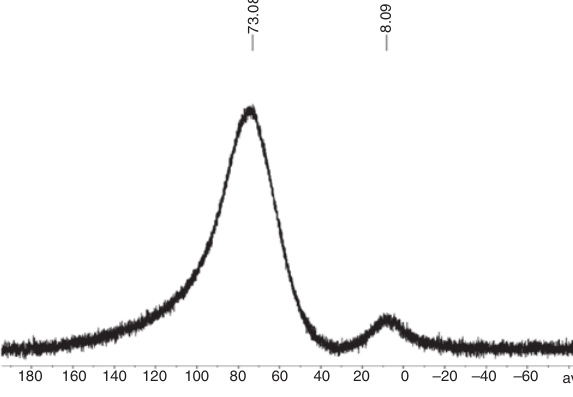
Figure 1: 27 Al NMR of [CH 3 C(O)C:C(O)N(Ph)N:CCH 3 ] 2 Al( µ -O Pr i )2Al(OPr i ) 2 ] [CH 3 C(O)C:C(O)N(Ph)N:CCH 3 ] 2 Al( µ -O Pr i )2Al(OPr i ) 2 ] ( 1